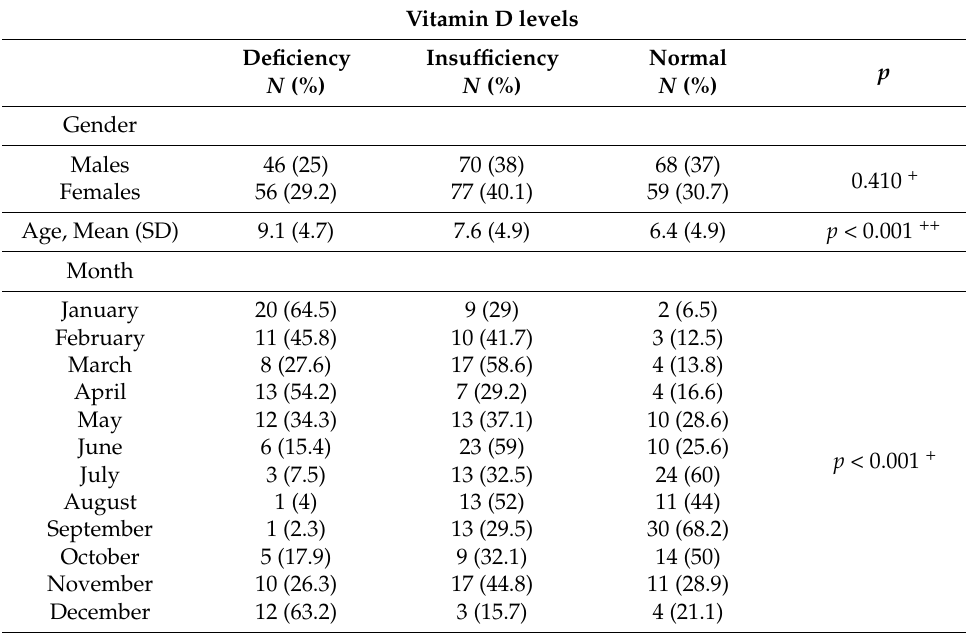
Table 2. Vitamin D (vit D, 25(OH)D) deficiency and insufficiency in healthy children in Greece, according to demographic characteristics, month, and season ( n =